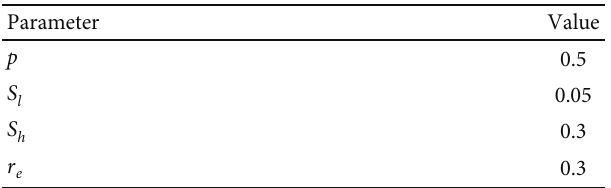
Table 2: Random erasing